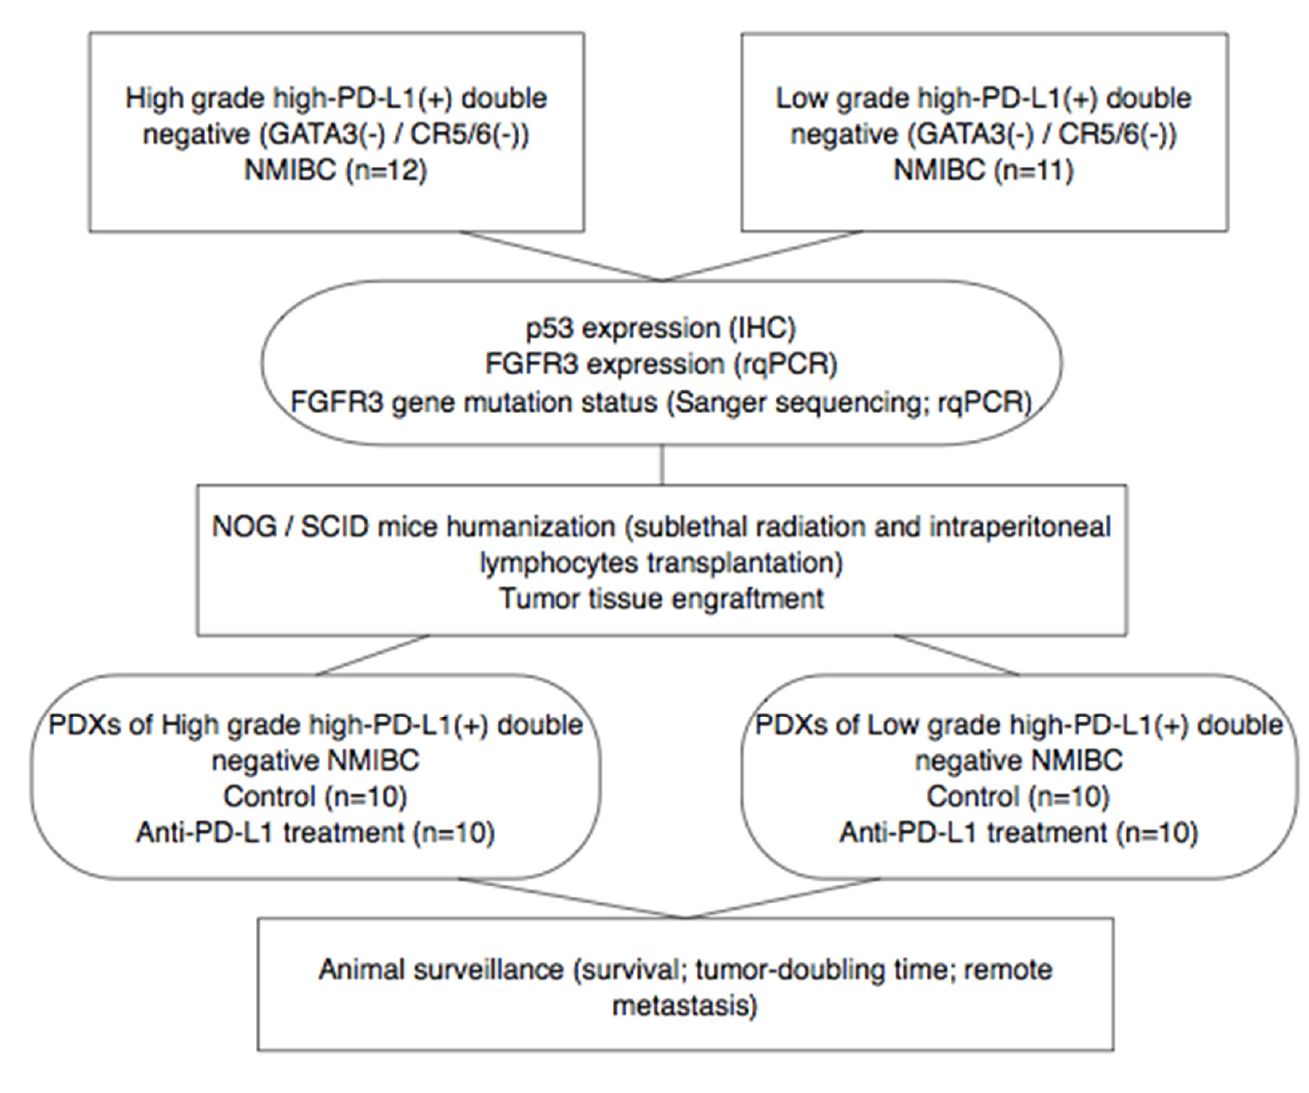
Figure A3. Study design.